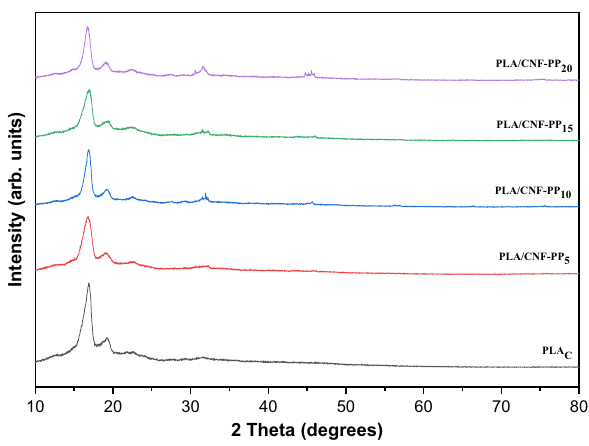
Figure 3: XRD analysis of PLA sca ff olds with di ff erent CNF contents.